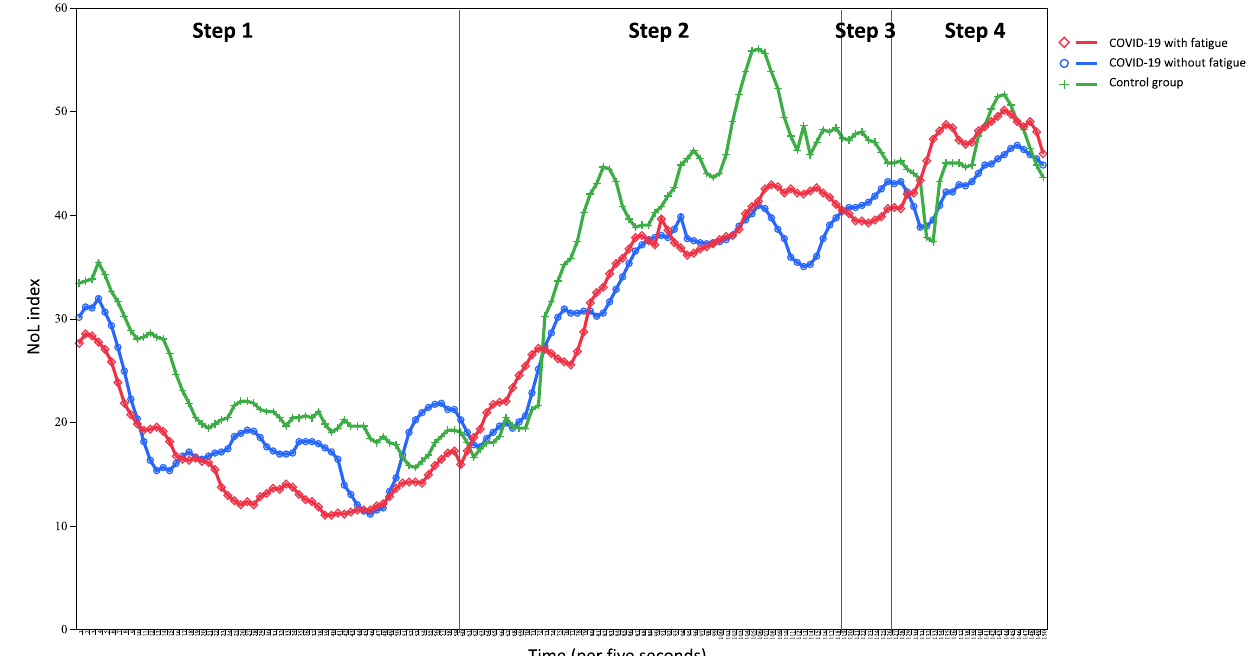
Figure 1. NoL index changes over time according to the group of participants. 12 participants with COVID-19 and fatigue; 15 participants with COVID-19 without fatigue, 12 control participants. Step 1 five minutes lying down; Step 2 five minutes standing; Step 3 thirty seconds of flexion/extension and step 4: two minutes sitting down. Measures were performed each five